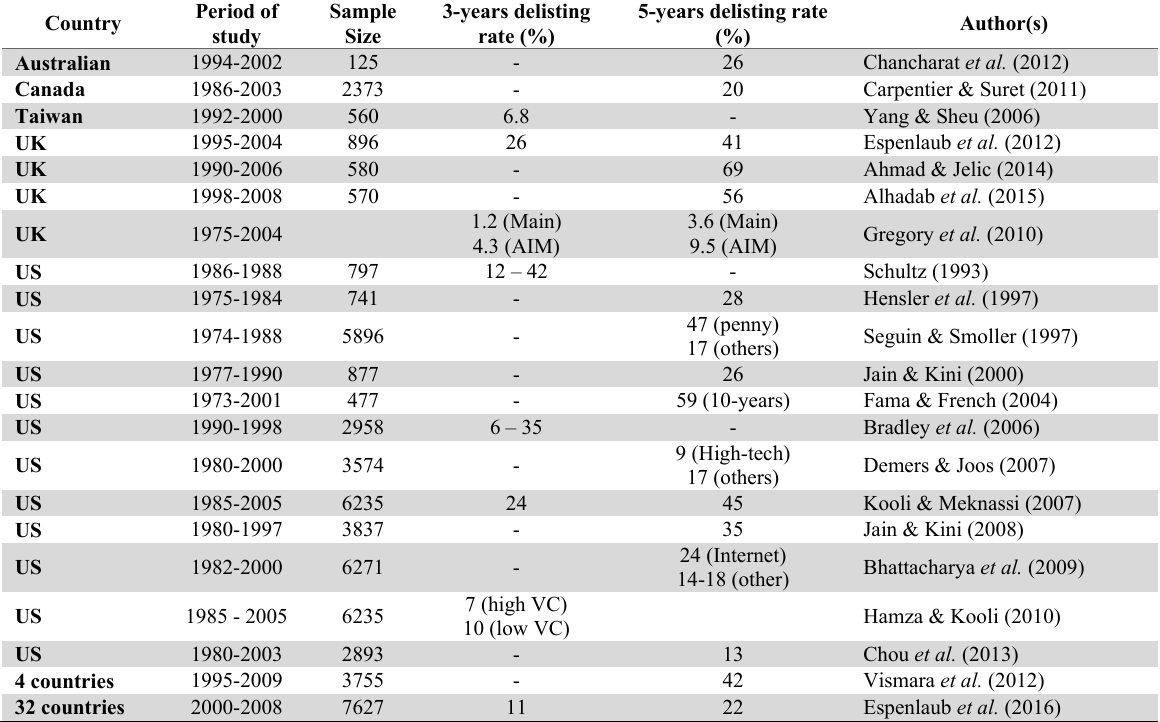
The Delisting Rate of IPOs in Various